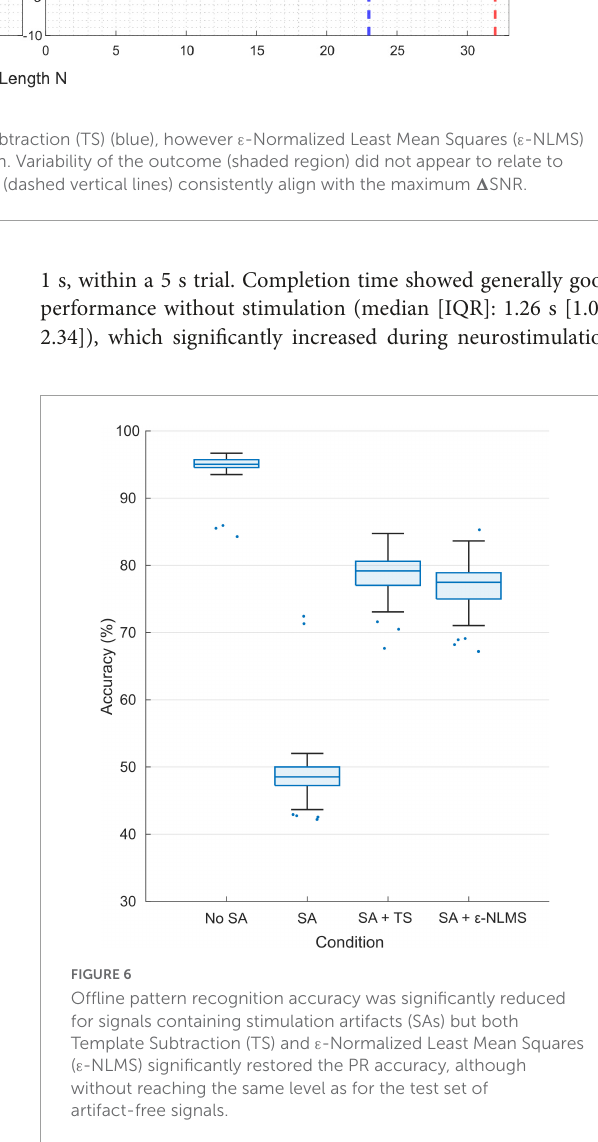
FIGURE6 Offline pattern recognition accuracy was significantly reduced for signals containing stimulation artifacts (SAs) but both Template Subtraction (TS) and ε -Normalized Least Mean Squares ( ε -NLMS) significantly restored the PR accuracy, although without reaching the same level as for the test set of artifact-free